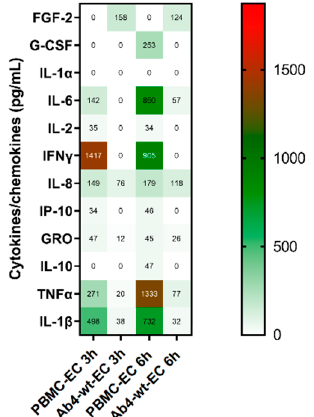
Figure 8. PBMC cytokine and chemokine profile of PBMC-EC co-culture at 3 and 6 h. Equine PBMC were infected with Ab4-wt at an MOI of 1. Infected PBMC were collected and co-cultivated with EC, incubated for 3 and 6 h, supernatants were collected, and cytokines / chemokines concentrations were measured using Milliplex ® MAP equine cytokine / chemokine magnetic bead-based Multiplex kit with Luminex-based detection system. Mean concentration of cytokines and chemokines were given in pg per mL; ( n =